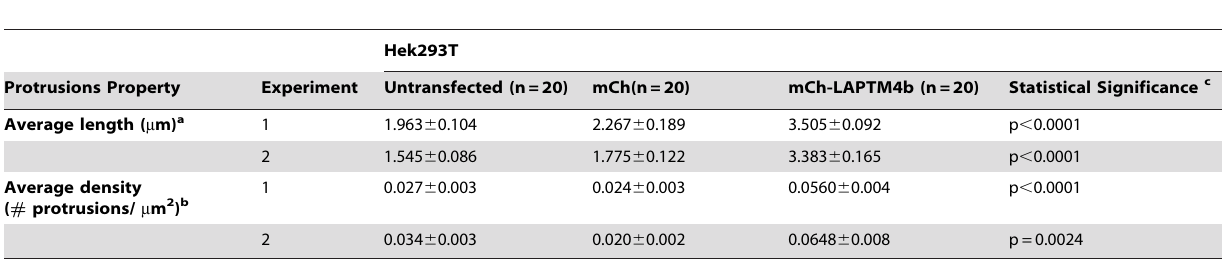
Table 2. Hek293T cells in which mCh-LAPTM4b is overexpressed have longer and higher density of actin-based membrane